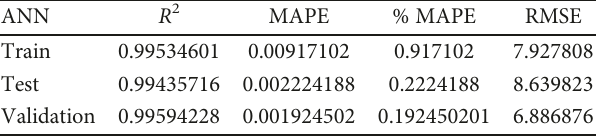
Figure 8: Neural network regression plots for test. Table 13: ANN error performance values (fsor